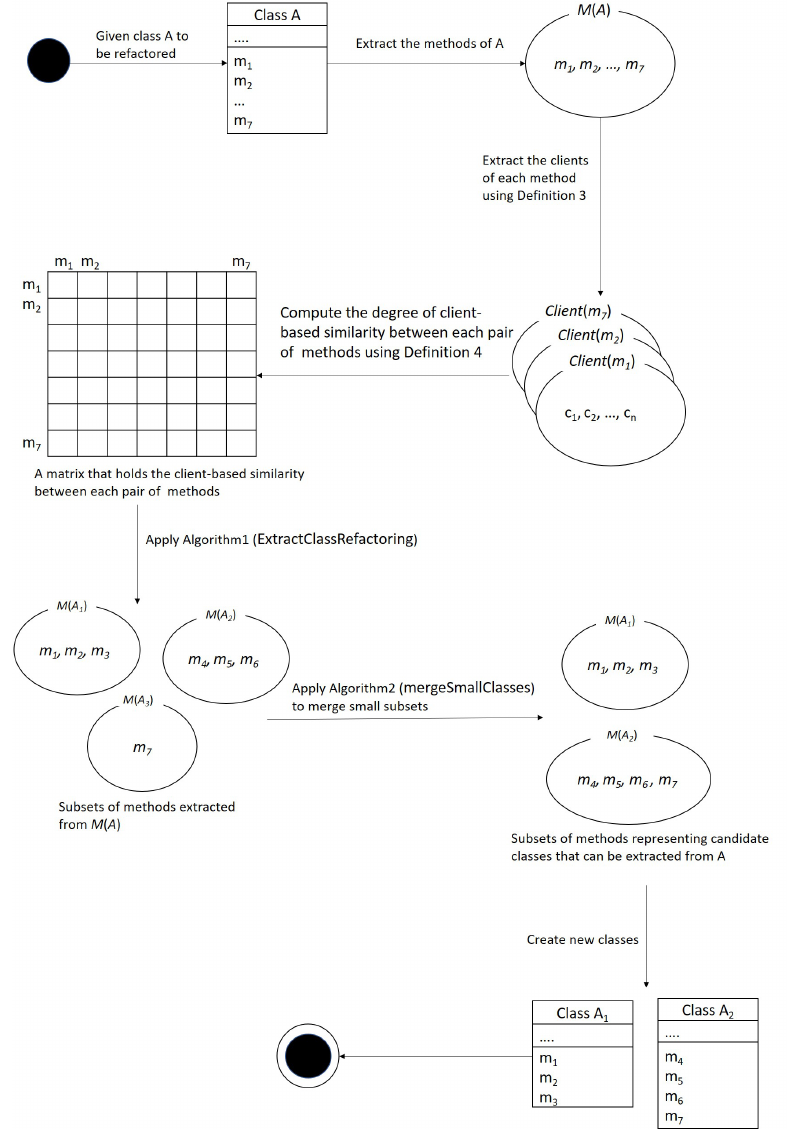
Figure 4. An outline of the main steps of our